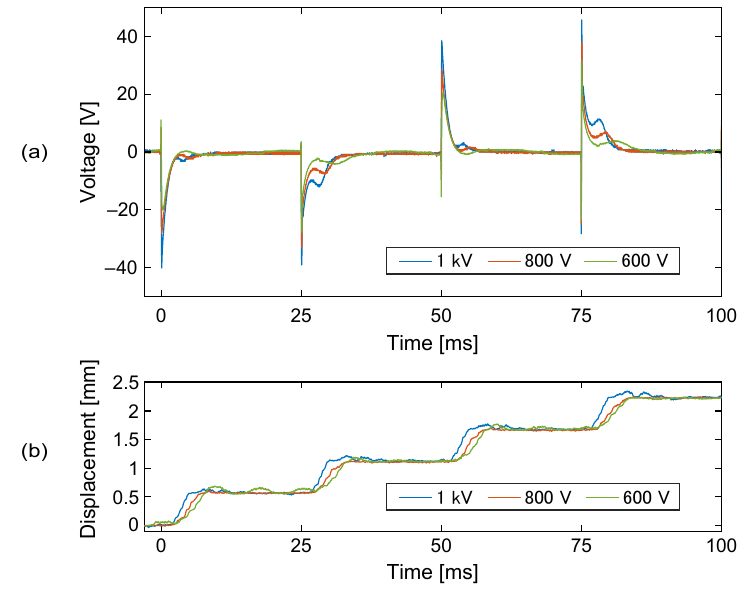
Figure 15. The voltages of the sensing electrode ( a ) and the slider displacement ( b ) when the actuator was operated by different driving voltage amplitudes, 600, 800, and 1000 V. As the driving voltage amplitude became smaller, the slider speed during the step movement became slower. As a result, the slider signal became weaker.